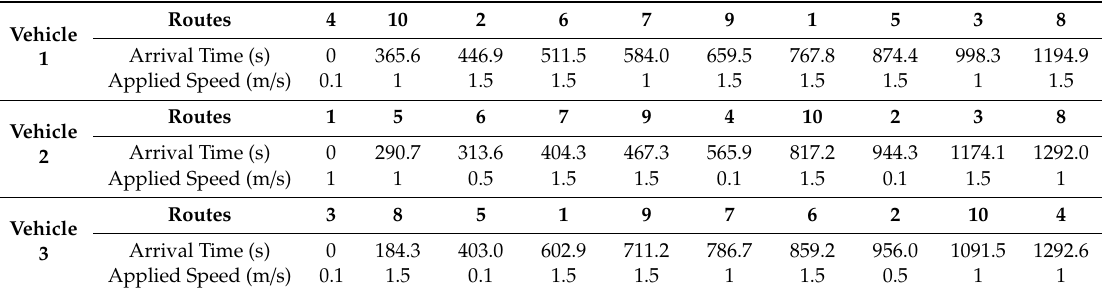
Table 6. Most near-optimal trajectories for t occ > 10 s.